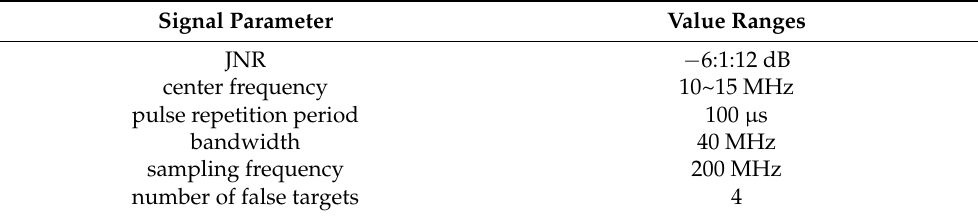
Table 1. Main simulation parameter settings for the jamming signals.